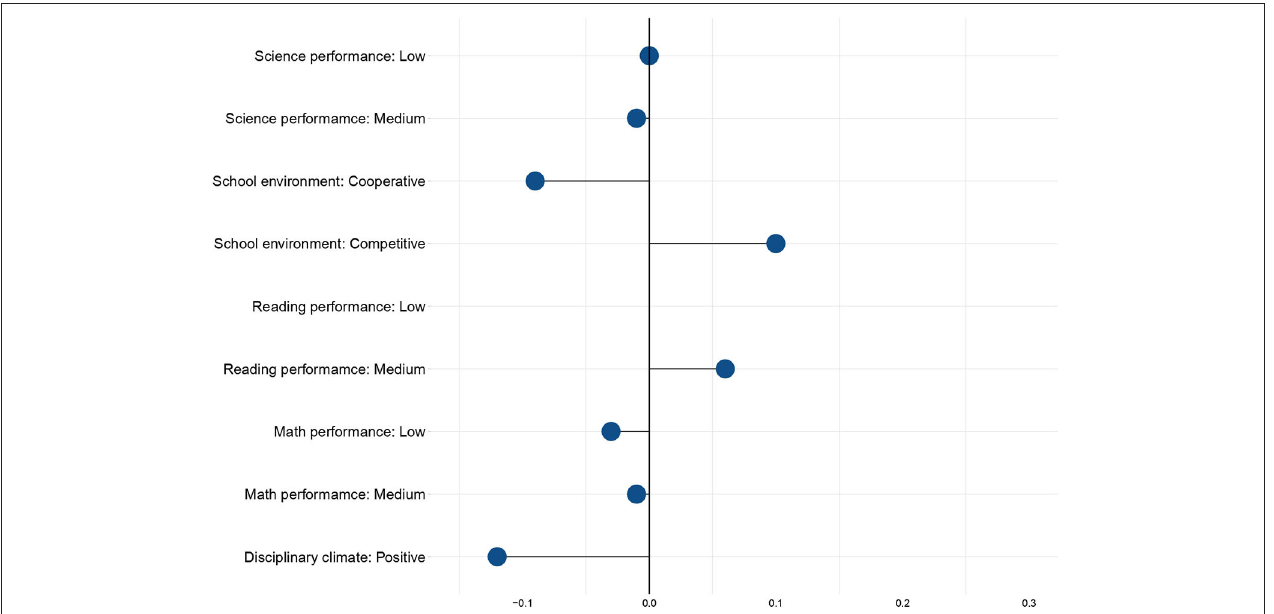
FIGURE 3 | Marginal effects of learning outcomes and the psychological environment of the school on the occurrence of bullying victimization. Source: Calculations of the authors based on PISA-2018 in Russia.